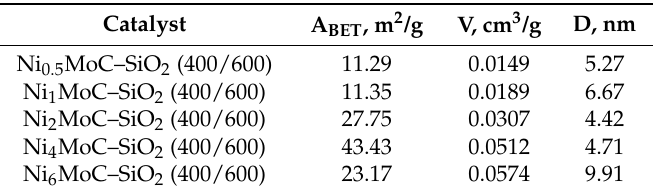
Table 6. The total surface area A BET , the average pore size D and the total pore volume V for the calcined and reduced Ni x MoC–SiO 2 (400/600)